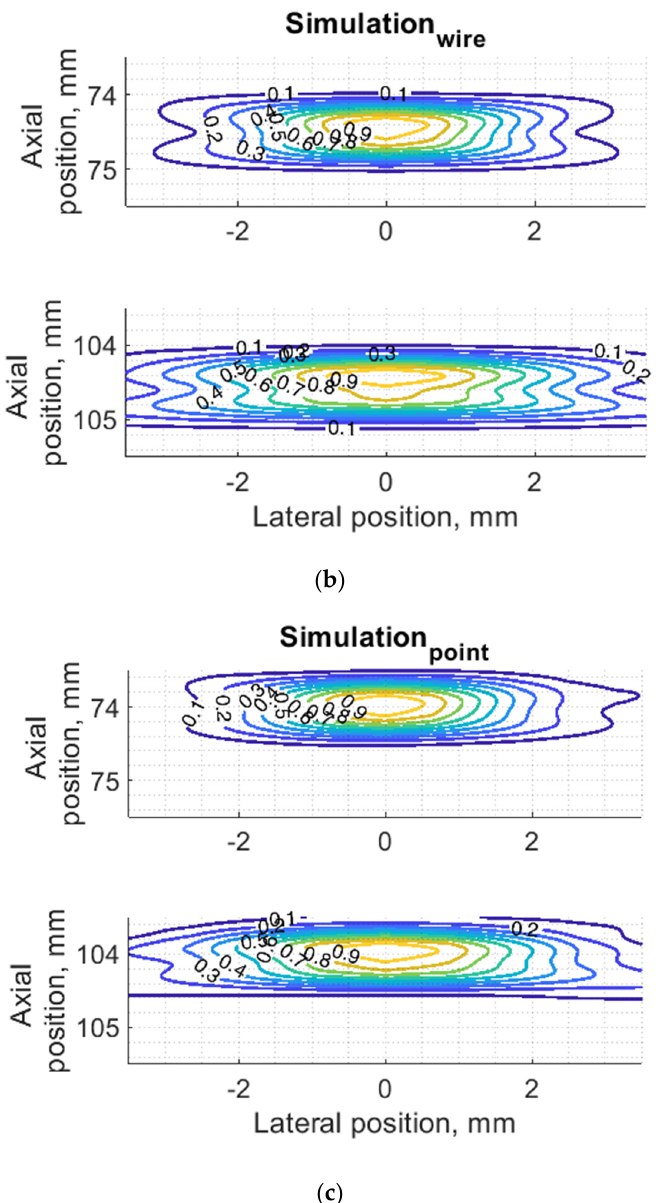
Figure 7. Comparison of PSF using isoline diagrams of RF signals reflected from targets at 74 and 100 mm: ( a ) experimental echoscopy of physical wire phantom, ( b ) simulation of wire phantom as wire scatterers, ( c ) simulation of wire phantom as point scatterers. Isolines presented at 0.1 intervals (from 0.1 to 0.9) of normalized envelopes of RF signals .